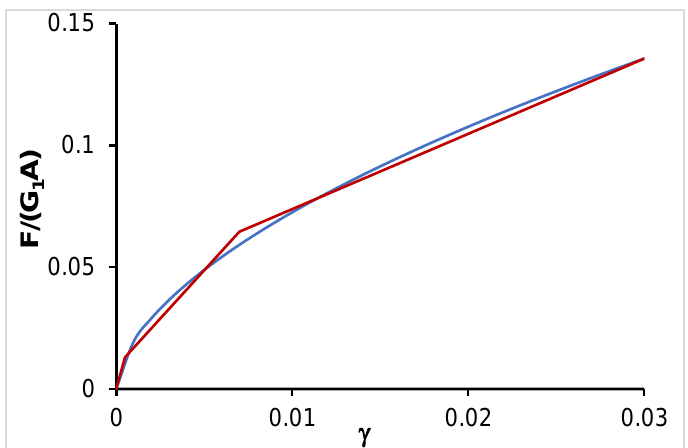
Figure 20. The non-linear relationship between force and shear strain for the elastomeric isolators,